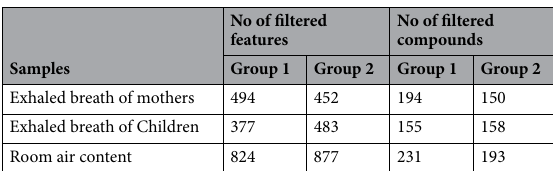
Table 2. Filtered features and filtered compounds.